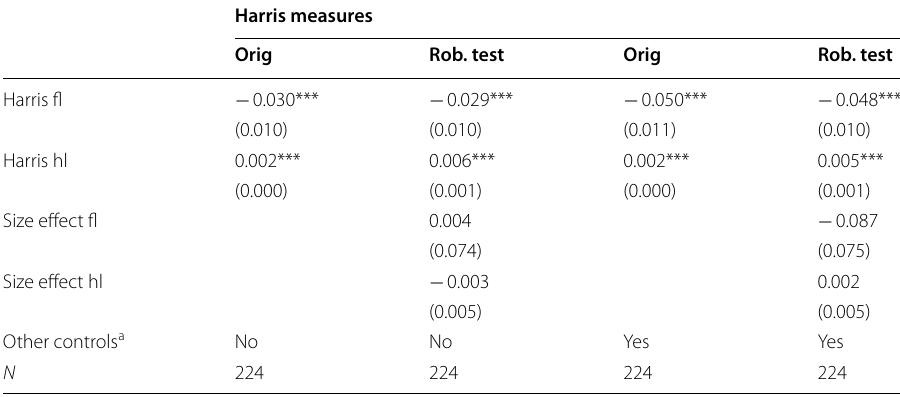
Table 5 Results of robustness